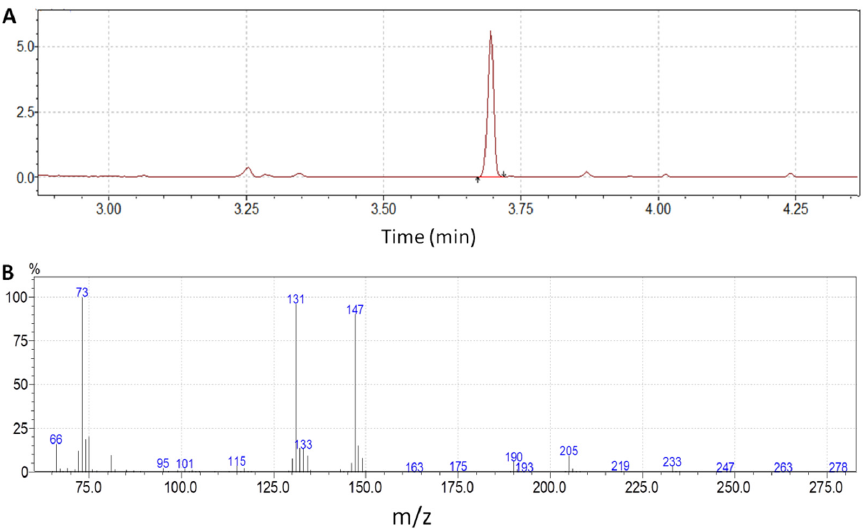
Figure 2. ( A ) Chromatogram of a serum sample ( m/z 205); ( B ) mass spectrum of 2HB di-TMS.